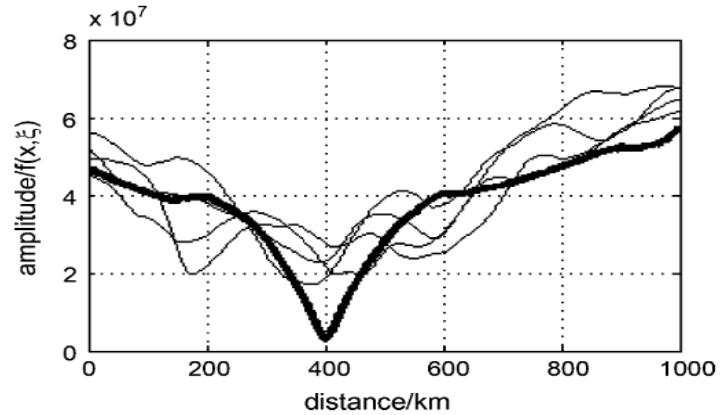
Figure 21. Voltage distribution curves at different fault locations.